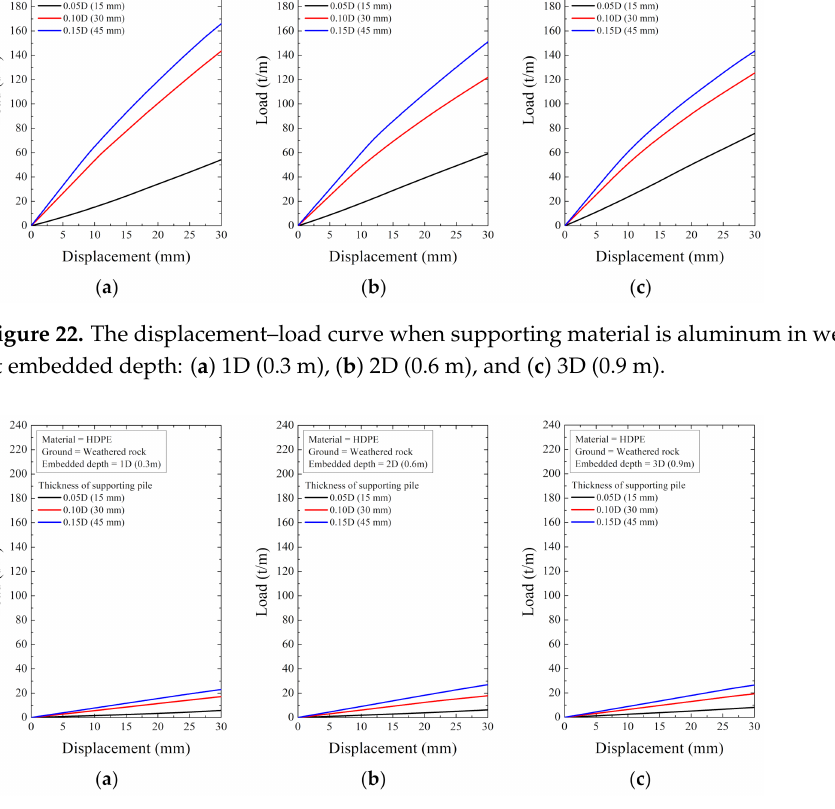
Figure 23. The displacement–load curve when supporting material is HDPE in weathered rock at embedded depth: ( a ) 1D (0.3 m), ( b ) 2D (0.6 m), and ( c ) 3D (0.9